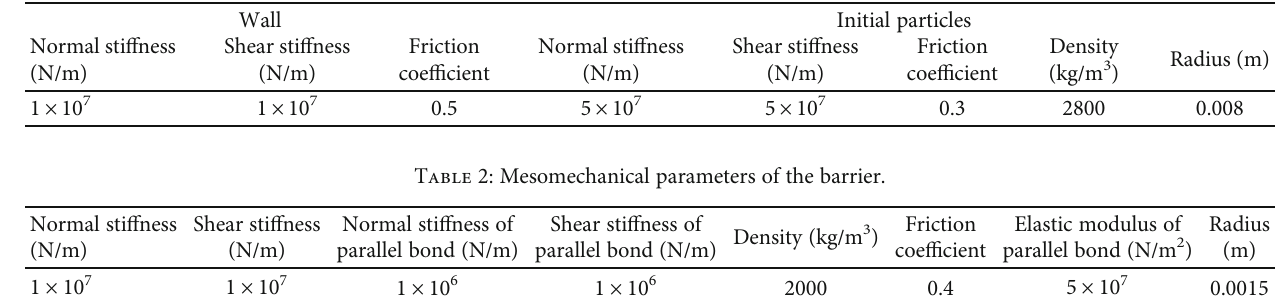
Table 1: Mesomechanical parameters of the walls and initial particles.